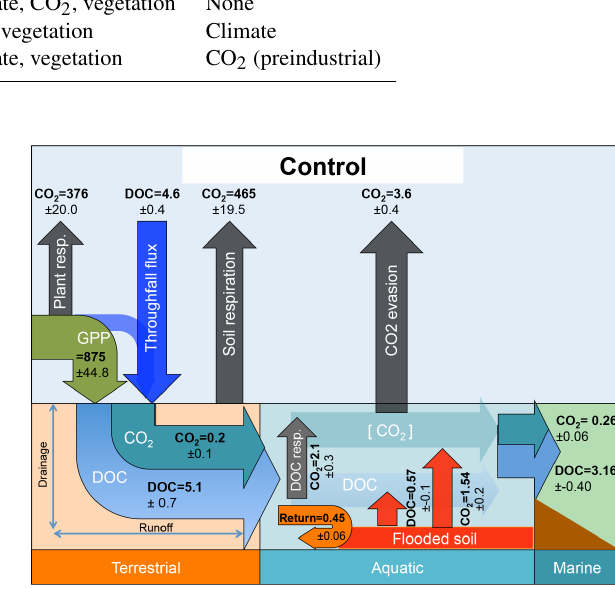
Figure 1. Flow diagram illustrating the stepwise stages required to set up the model, up to and including the historical period. The two stages that refer to the inverted reading of restart soil profile order point to the fact that the restart inputs from ORCHIDEE-MICT are read by our model in inverse order, so that 1 year must be run in which an activated flag reads it properly, before the reading of soil profile restarts is reinverted for all subsequent years.